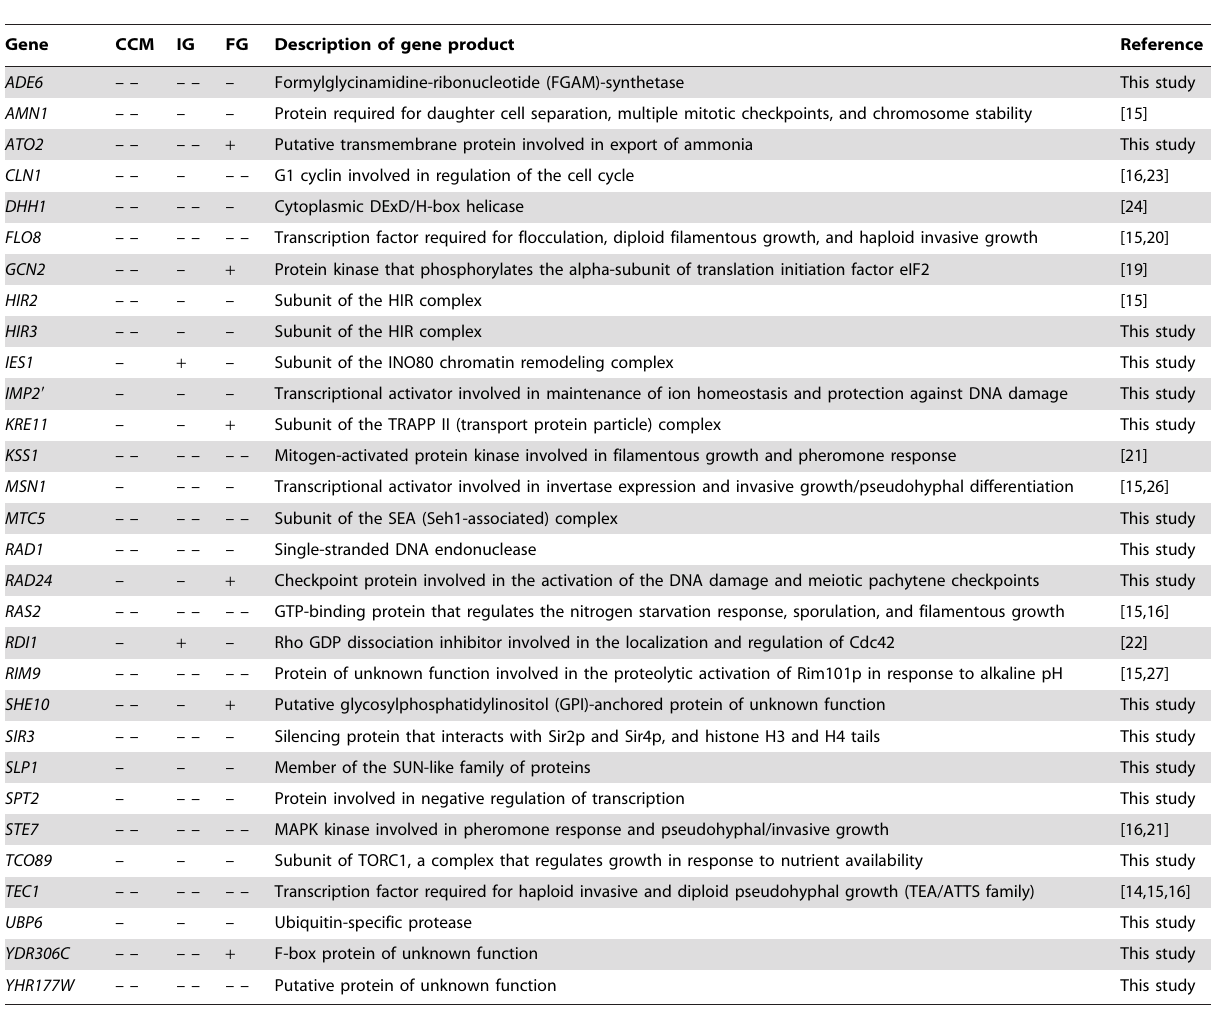
Table 1. Identified mutations that suppress enhanced morphological developments of the homozygous hog1 D /hog1 D c strain.